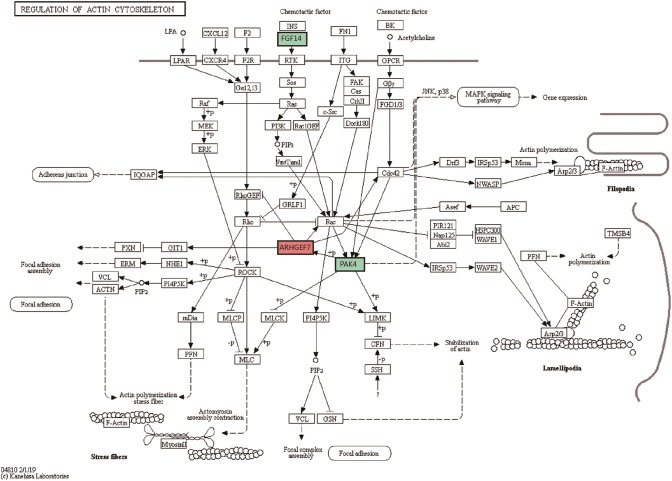
Signaling pathways regulating the actin cytoskeleton. Diagram of the most significant signaling pathways in which the differentially expressed genes in the XYS group were involved compared with the model group. The green label represents the downregulated FGF14 and PAK4 genes; the red label represents the upregulated ARHGEF7 gene.